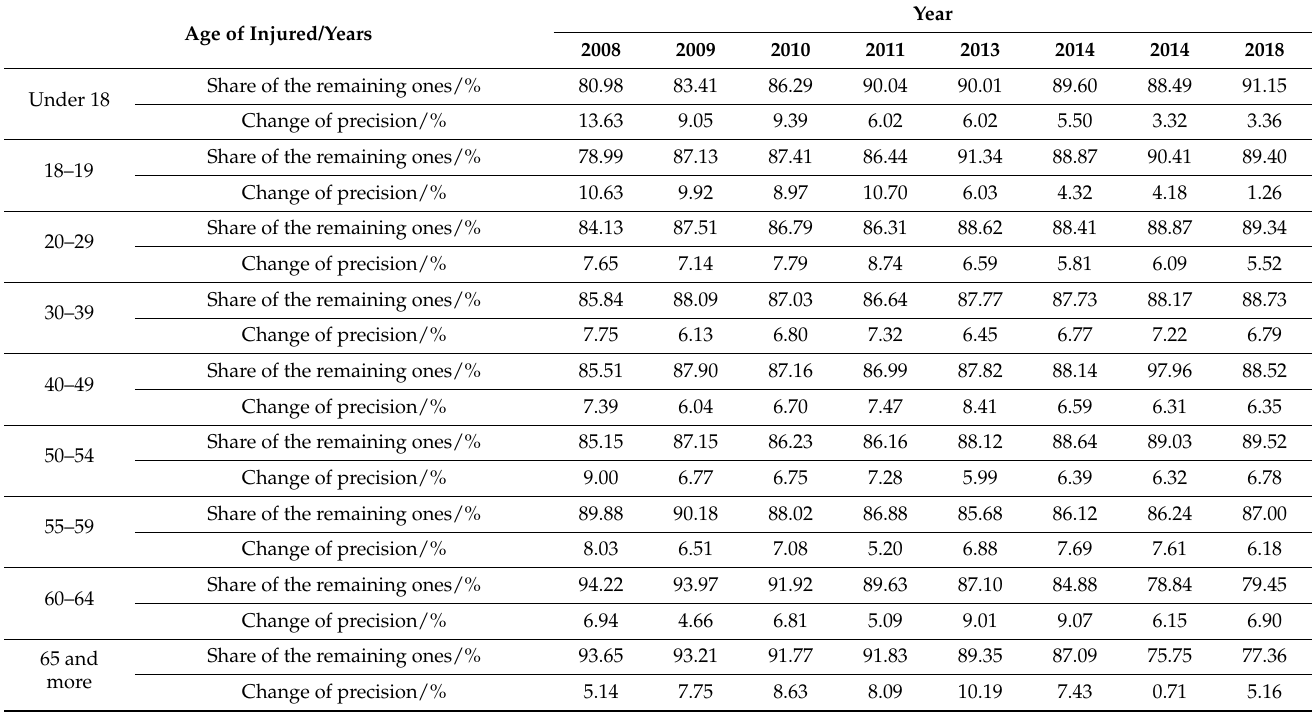
Table 4. Sensitivity of the relative risk of an accident at work after deleting data (own elaboration). Age of